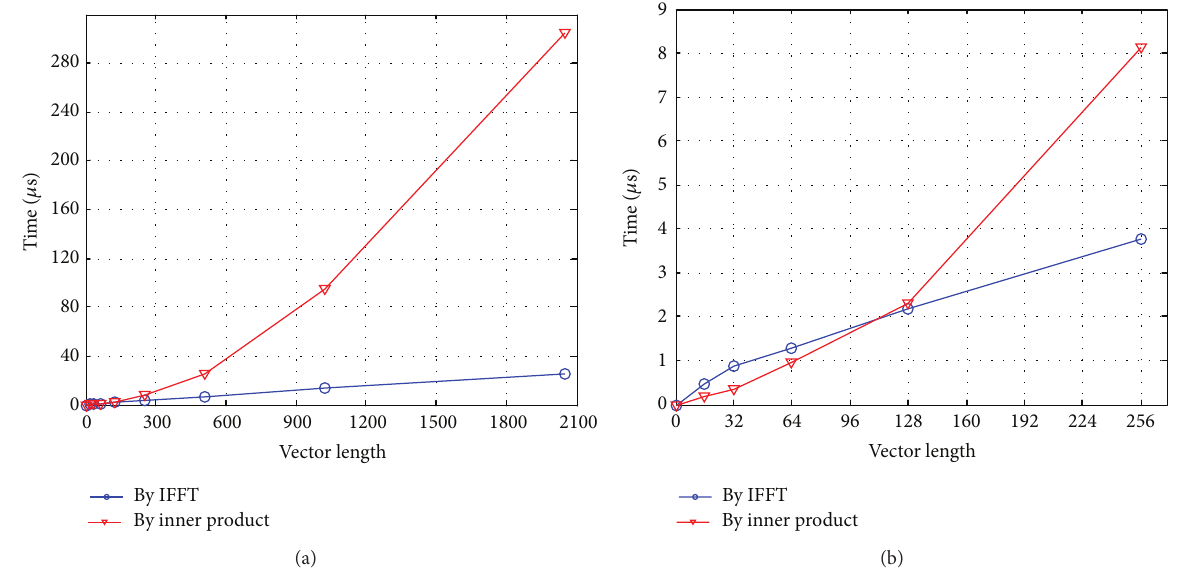
Figure 5: (a) Computing time of IFFT and inner product. (b) Partial enlarged drawing of (a). Table 2: Comparison between proposed approach and some other